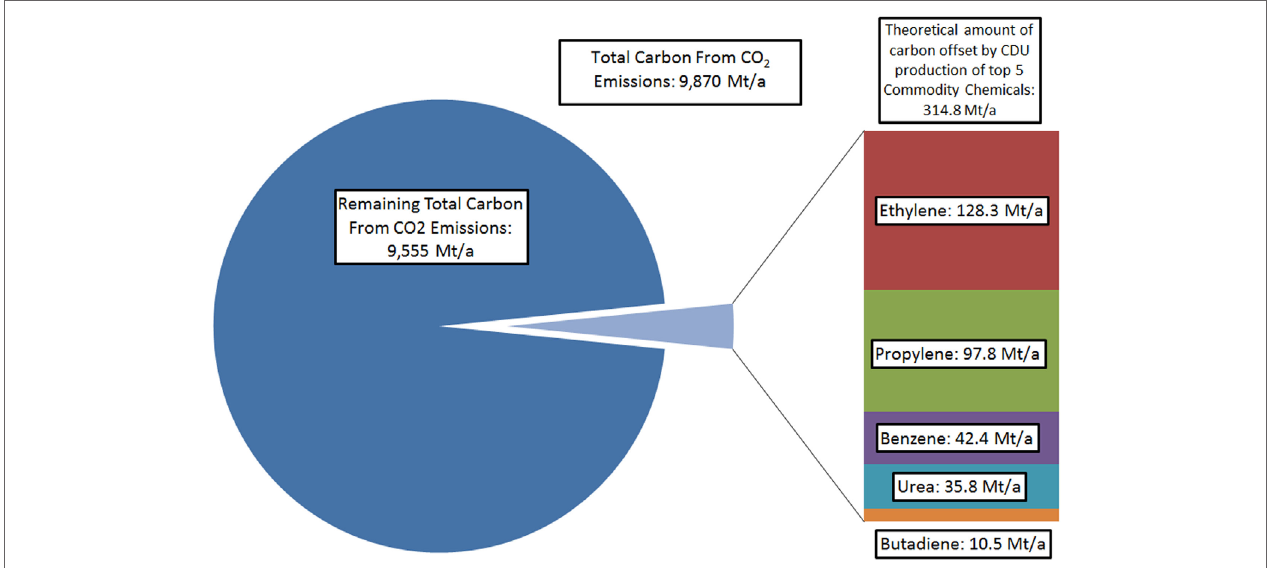
FigUre 1 | Comparison of total carbon in global CO 2 emissions compared to carbon atoms contained in five major carbon-containing commodity chemicals, avoiding derivatives such as ethylene oxide. 2015 figures used (Levdikova, 2014; Yennigallla, 2015; Heffer and Prud’homme, 2015; Coombs,